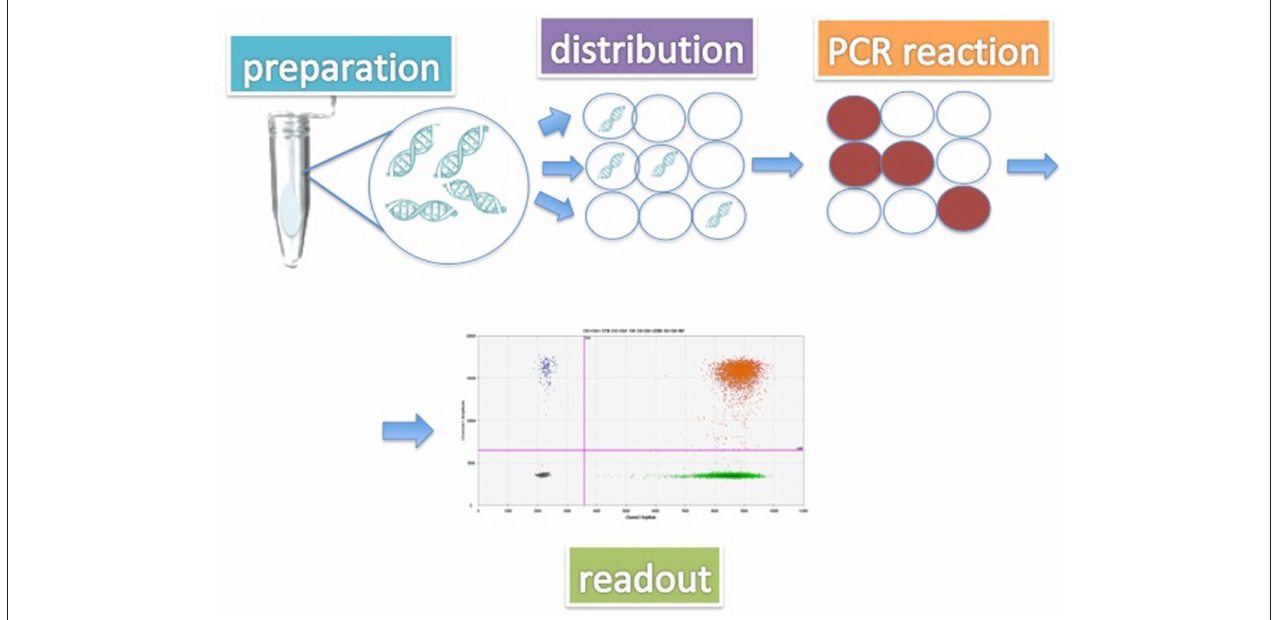
FIGURE 4 | Digital PCR (dPCR) overview. The fundamental phases of the process are represented: (1) partitioning of the sample in thousand of drops; (2) amplification; (3) output and digital analysis.